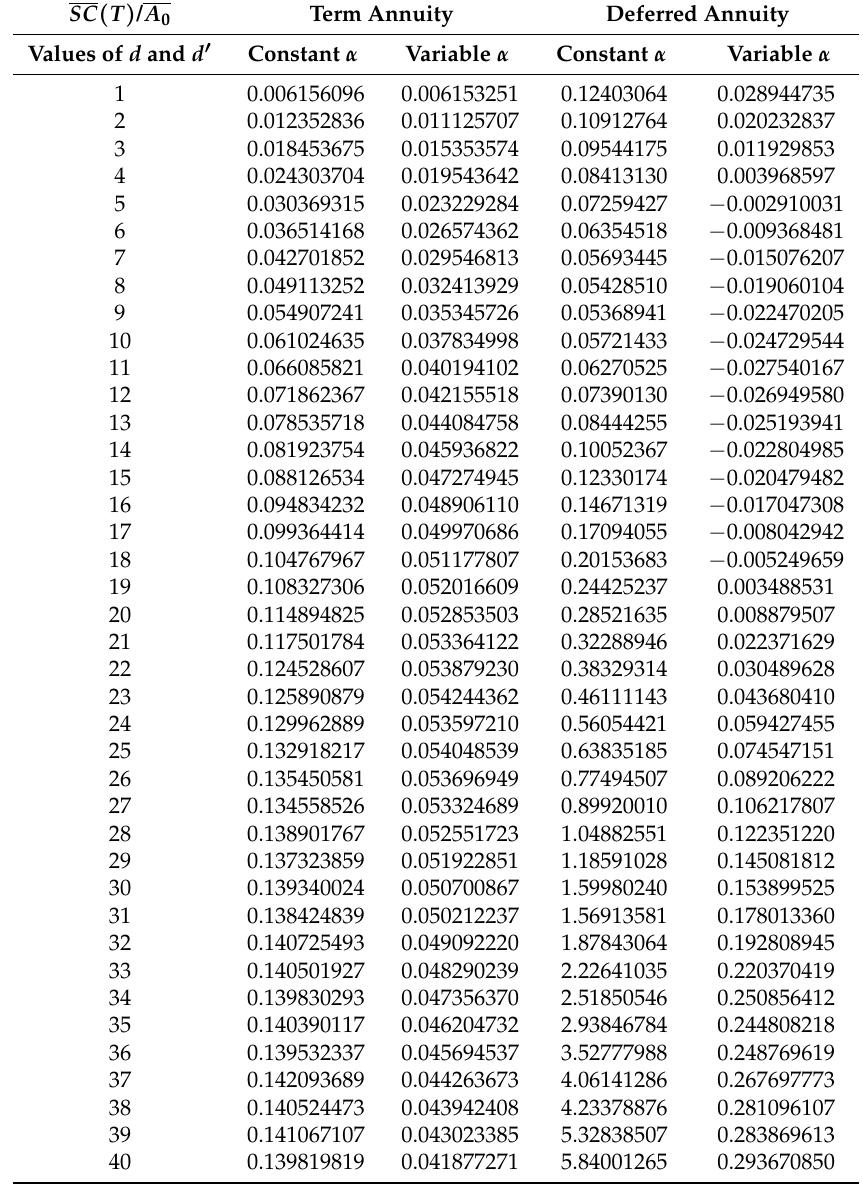
Table A1. Comparison of annuities for t = 0 and d (cid:48) , d =